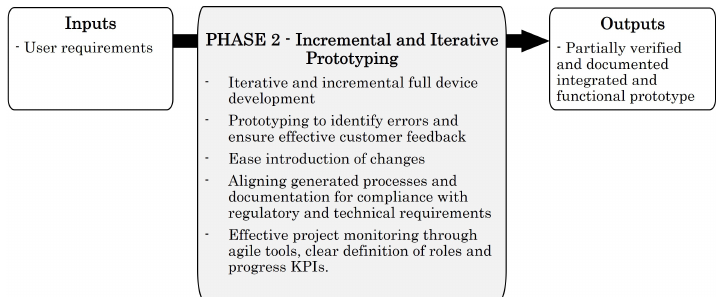
Figure 11. Incremental and Iterative prototyping phase: key characteristics, inputs and